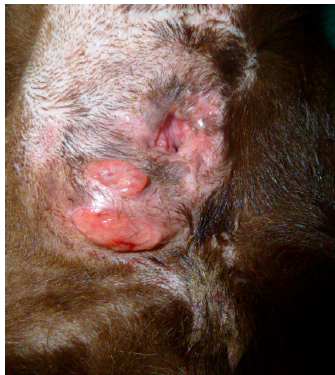
Figure 1. Pre-treatment. Figure 1.